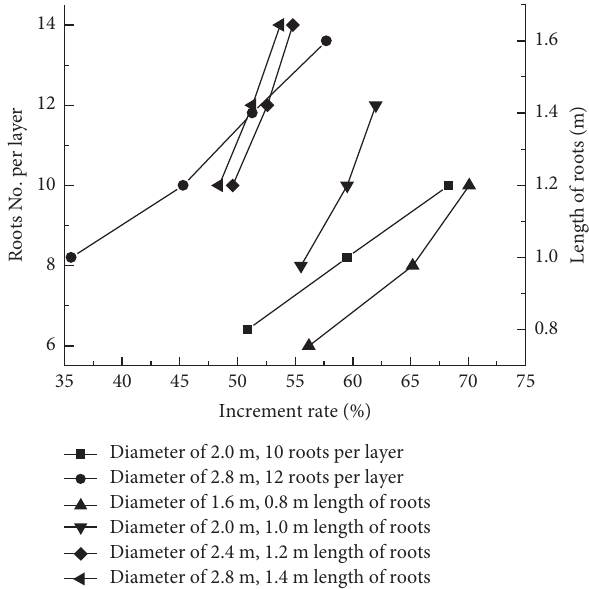
Figure 14: Q u increment of RP with different number and length of roots. Table 5: Simulation programs and results of hollow